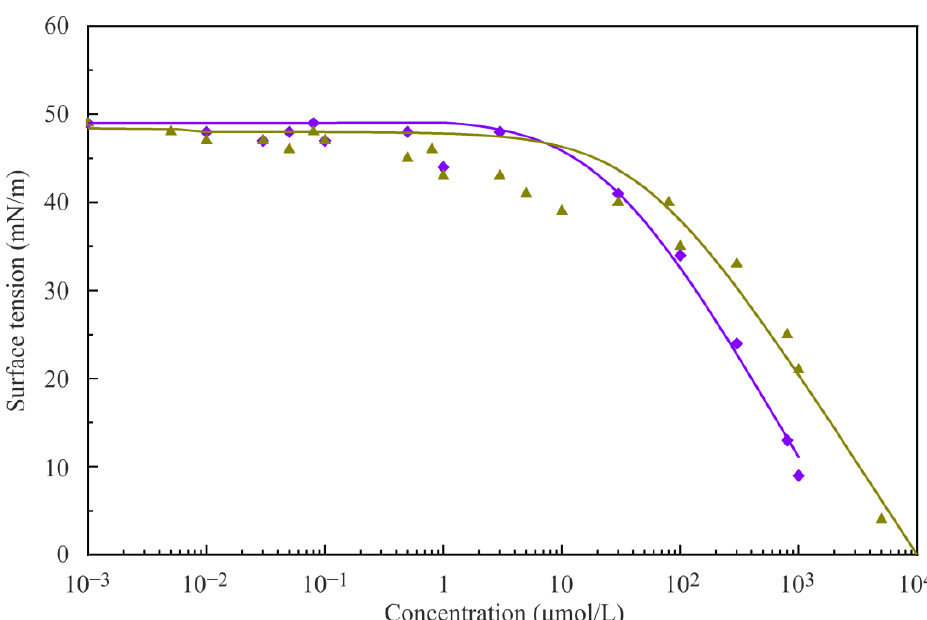
Figure 2. Equilibrium interfacial tension measured by profile analysis tensiometry (PAT) at the solution/hexane interface as a function of the total bulk concentration c of mixtures: ( ) NaC 12 SO 4 + C 6 TAB and ( ) NaC 6 SO 4 + C 12 TAB; the solid lines are the fitting results for a Frumkin adsorption model given by Equations (1)–(3). Table 1. Parameter values obtained by fitting the Frumkin adsorption model Equations (1)–(3) to the experimental data of Figure 1.